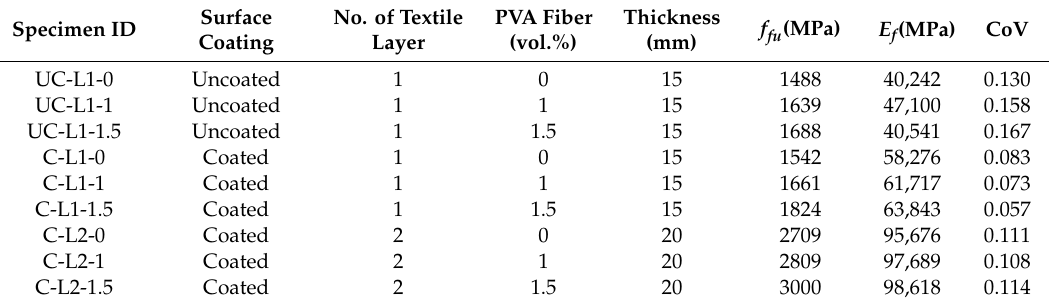
Table 4. Summary of the results for direct tension tests (average values of ten tests).